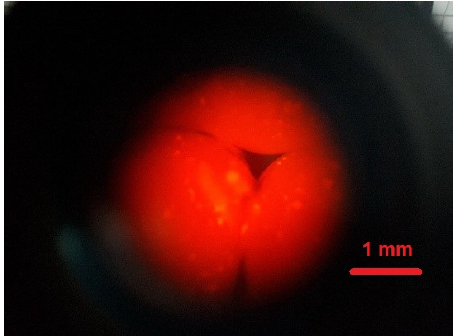
Figure 9. Epifluorescence showing a nonhomogeneous distribution of Rhodamine B dye in different chitosan microcapsules. Table 3. The main features of fluorescent MPs/NPs proposed for bioimaging.